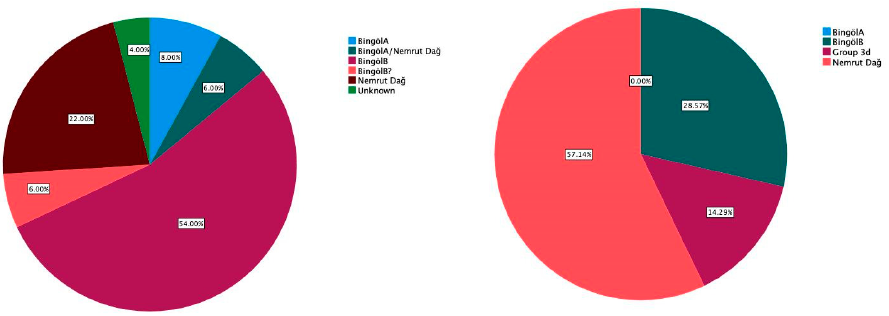
Figure 13. Proportion of main sources at Gre F ı lla (PPNB) and Kendale Hecala II (Ubaid